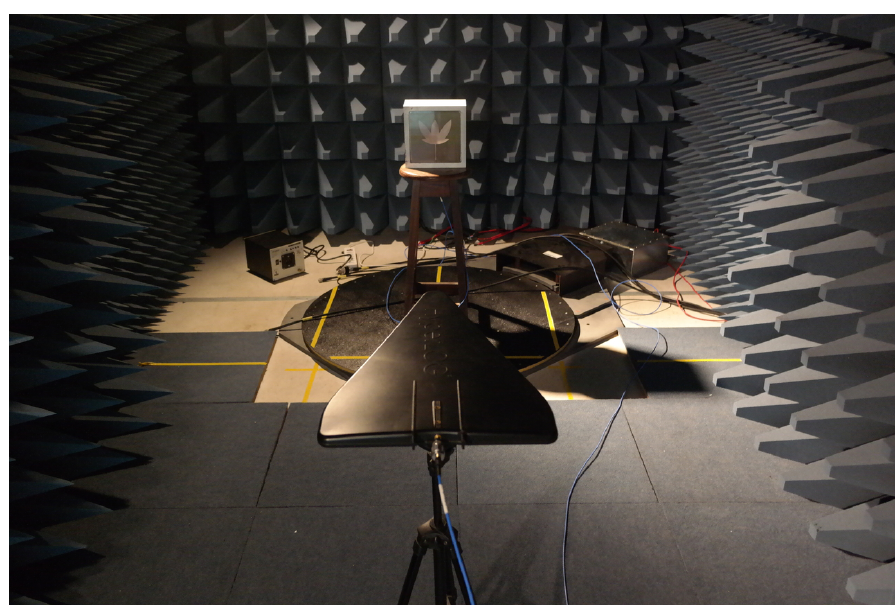
Figure 12. Gain measurement setup.